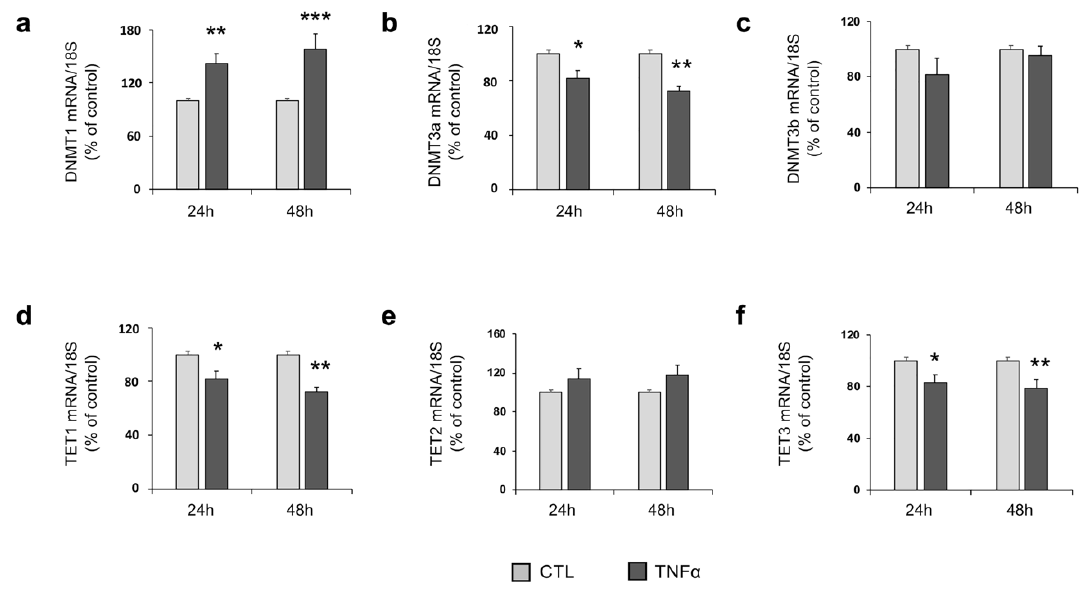
Figure 4. TNF α affects DNA Methyltransferases (DNMTs) and Ten Eleven Translocation (TETs) mRNA levels. ( a ) DNMT1, ( b ) DNMT3a, ( c ) DNMT3b, ( d ) TET1, ( e ) TET2 and ( f ) TET3 mRNA